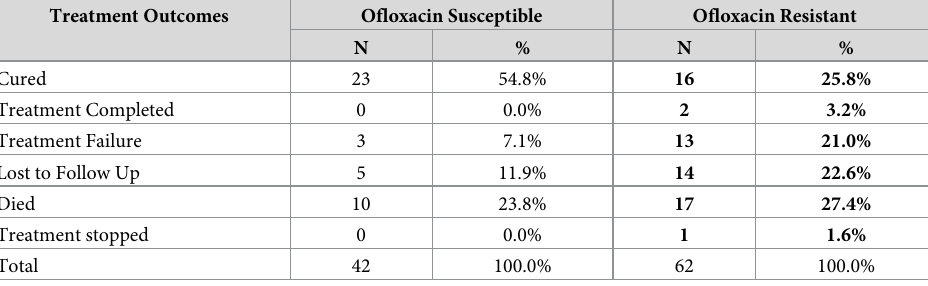
Table 6. Subgroup analysis of treatment outcome on MDR- TB patients with baseline SL DST (N =